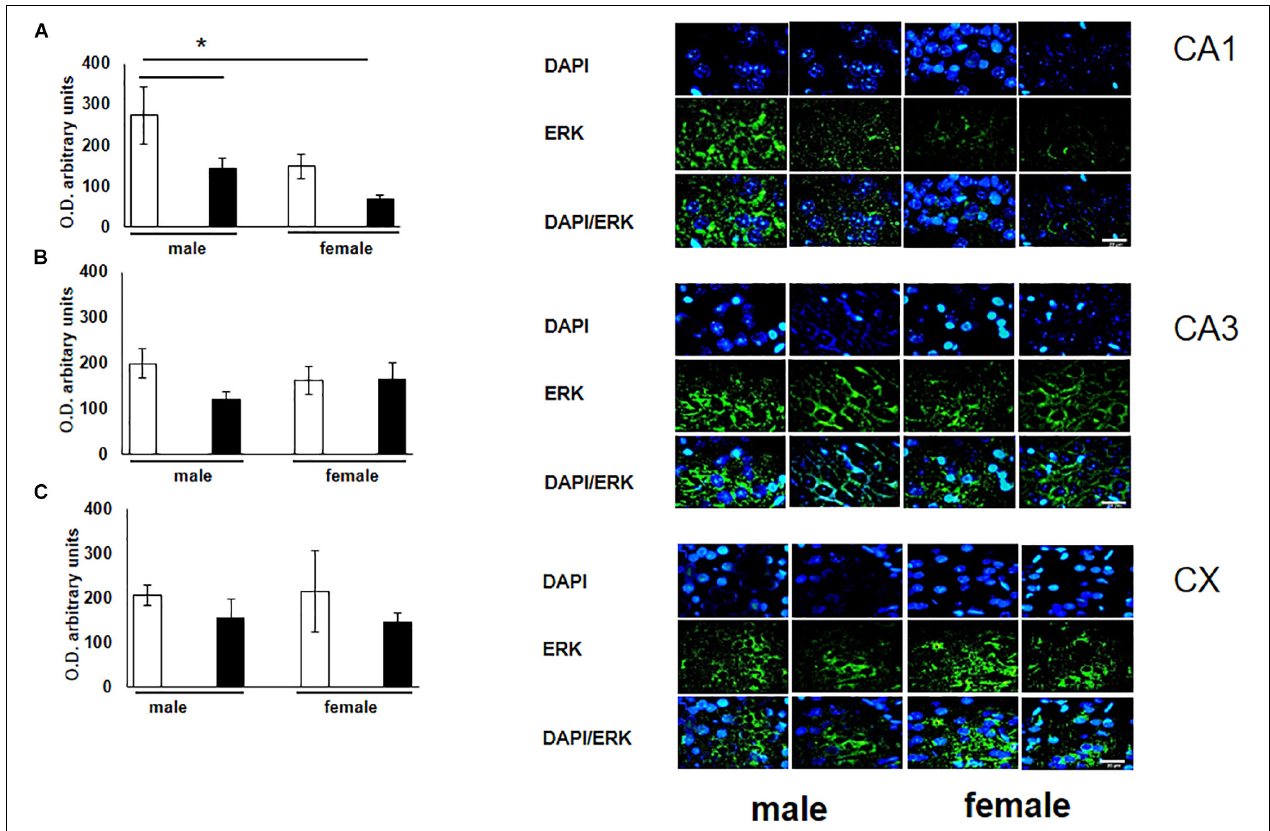
FIGURE 4 | Representative microphotography (objective 60 × and zoom 1.6 × ) showing immunopositivity for the ERK (green) and DAPI-stained nuclei (blue). The graph indicates optical density arbitrary units for control group (white bars) and ozone group (black bars) in male and females, (A) CA1, (B) CA3 and (C) CX. We observed a statistically significant decrease in the expression of ERK in the CA1 subfield in both males and females exposed to ozone. Bars indicate the mean ± SEM, using univariate comparison statistics. ∗ P ≤ 0.05. Scale bar = 20 µ